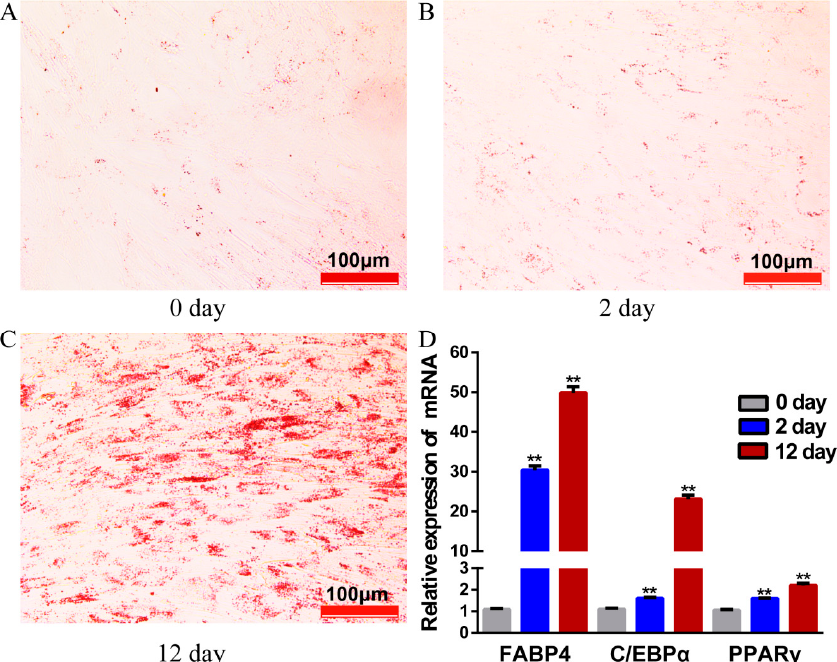
Figure 1. The yak preadipocytes and adipocytes for high-throughput sequencing. ( A–C ) Preadipocytes stained with Oil Red O on days 0, 2 and 12 of their differentiation. ( D ) The relative expression of genes PPAR γ , C/EBP α and FABP4 detected by qRT- PCR. Values are means ± SEM(Standard Error of Mean) ( n = 3);** p < 0.01. Genes 2020 , 11 , x FOR PEER REVIEW